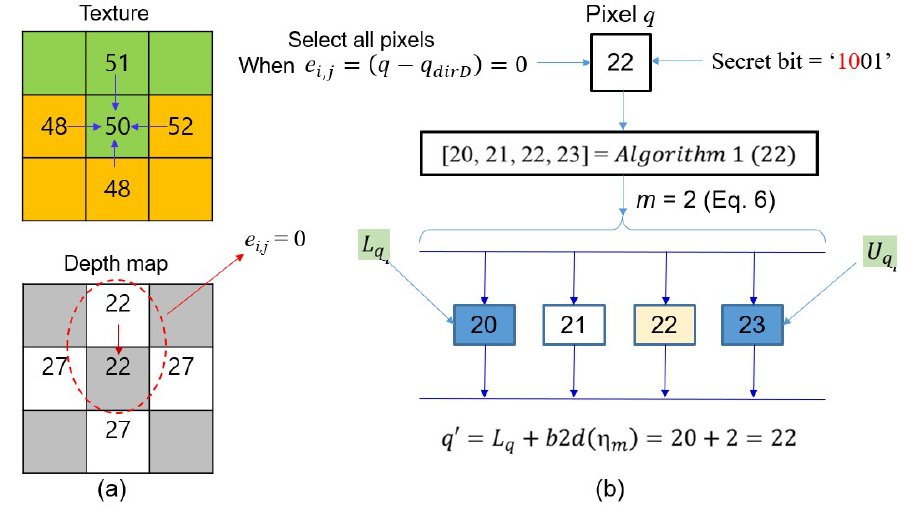
Figure 4. Example of the data embedding using the proposed